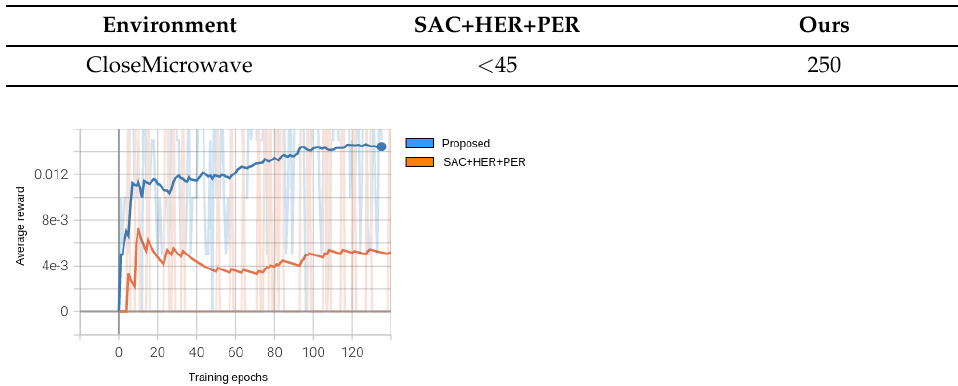
Table 5. Number of total successful attempts.